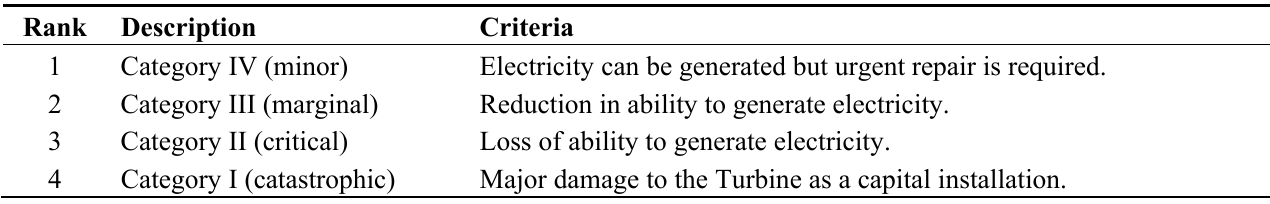
Table 4. Wind turbine FMEA ratings for detection of a failure (